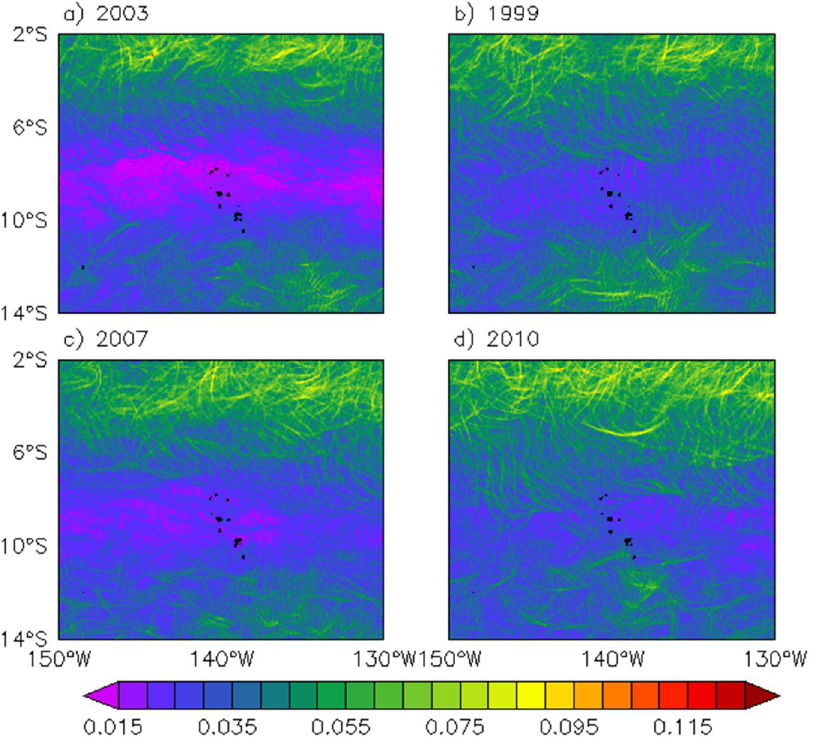
Figure 5. Annual RMS of FLSE for ( a ) a neutral year (as in 2003); and during La Niña events as in ( b ) 1999; ( c ) 2007; and ( d ) 2010.